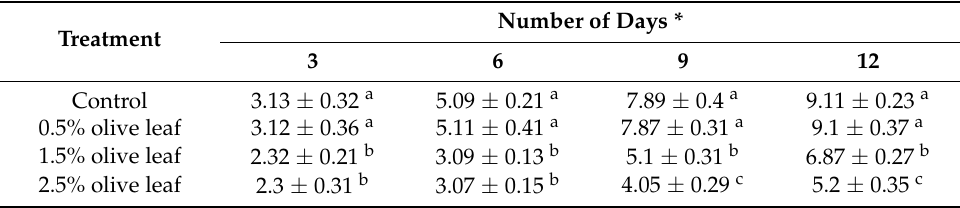
Table 4. Effect of the olive leaf extract on total coliform bacteria (log CFU/g) of the sheep meat slides stored at 5 ◦ C for 12